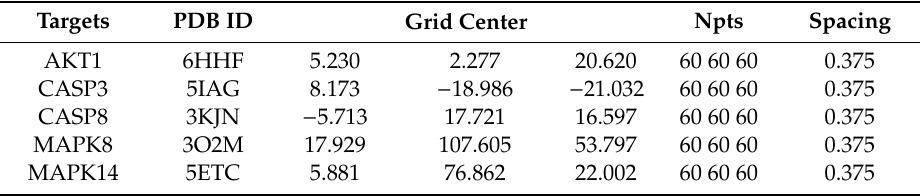
Table 4. Parameters of the grid box in molecular docking.